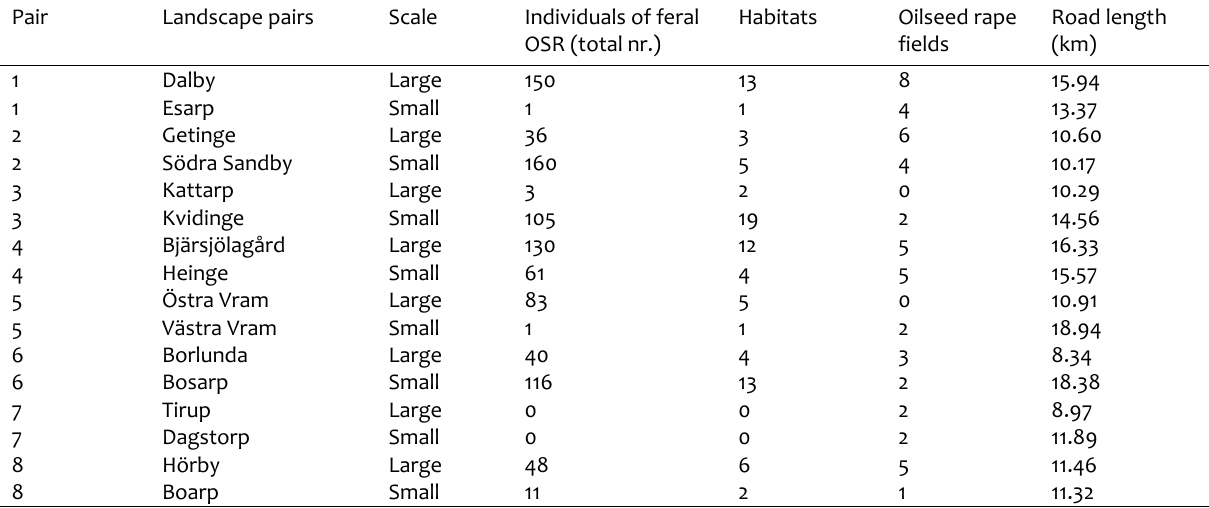
Table 1.A compilation of the field inventories showing the number of feral oilseed rape (OSR) individuals per circular landscape pair (large vs. small), the number of habitats and cultivated oilseed rape fields, and the calculated total length of road within each circular landscape. Large- and small-scale landscapes are defined in the methods section. Pair Landscape